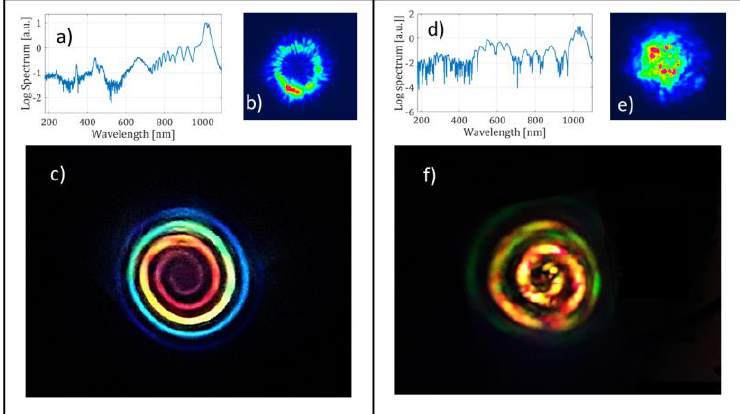
Fig. 1 Experimental results obtained in a 50/125 GRIN fiber (left panel) and Step-index fiber (right panel); a) Output spectrum at 25 MW input peak power (logarithmic scale); b) near field; c) far field. In Figs.1.a, the output spectrum shows an ultrabroadband distribution, ranging from the UV up to the pump wavelength. The near-field profile at the fiber output shows that the supercontinuum only propagates inside the cladding (see Figs. 1.b). Finally, the far-field SSE is shown in Figs. 1.c. In Fig1 d)-f) we show how the spectrum, the near- and far-field profiles change when the input coupling condition is slightly changed. The spiral-shaped emission is maintained. However, the supercontinuum distribution no longer shows a spatially separated spectral distribution. Moreover, the near-field manifests the typical multimodal speckled profile. A theoretical model able to describe SSE generation is being